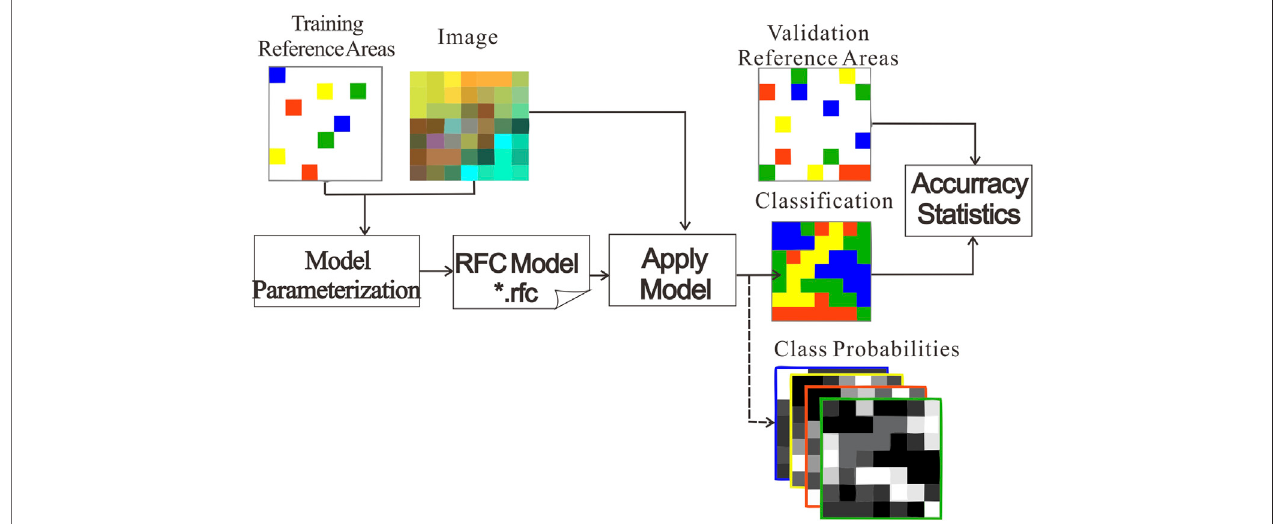
FIGURE 6 | Work fl ow of parameterization, application, and assessment of the random forest classi fi cation (RFC) model in the ImageRF toolbox of EnMAP-Box v2.2.1.